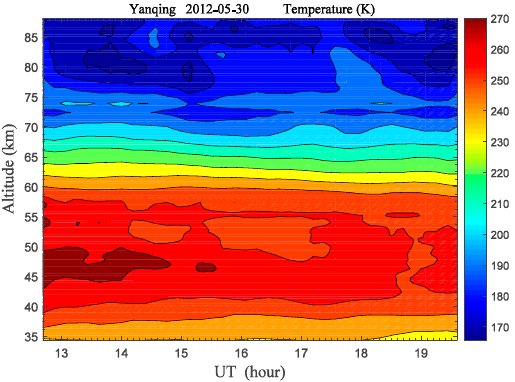
Figure 2. Atmospheric temperature structure (35–87 km) derived from the dual-wavelength Rayleigh lidar observations at Yanqing (40.5° N, 116° E) at nighttime on 30 May 2012.